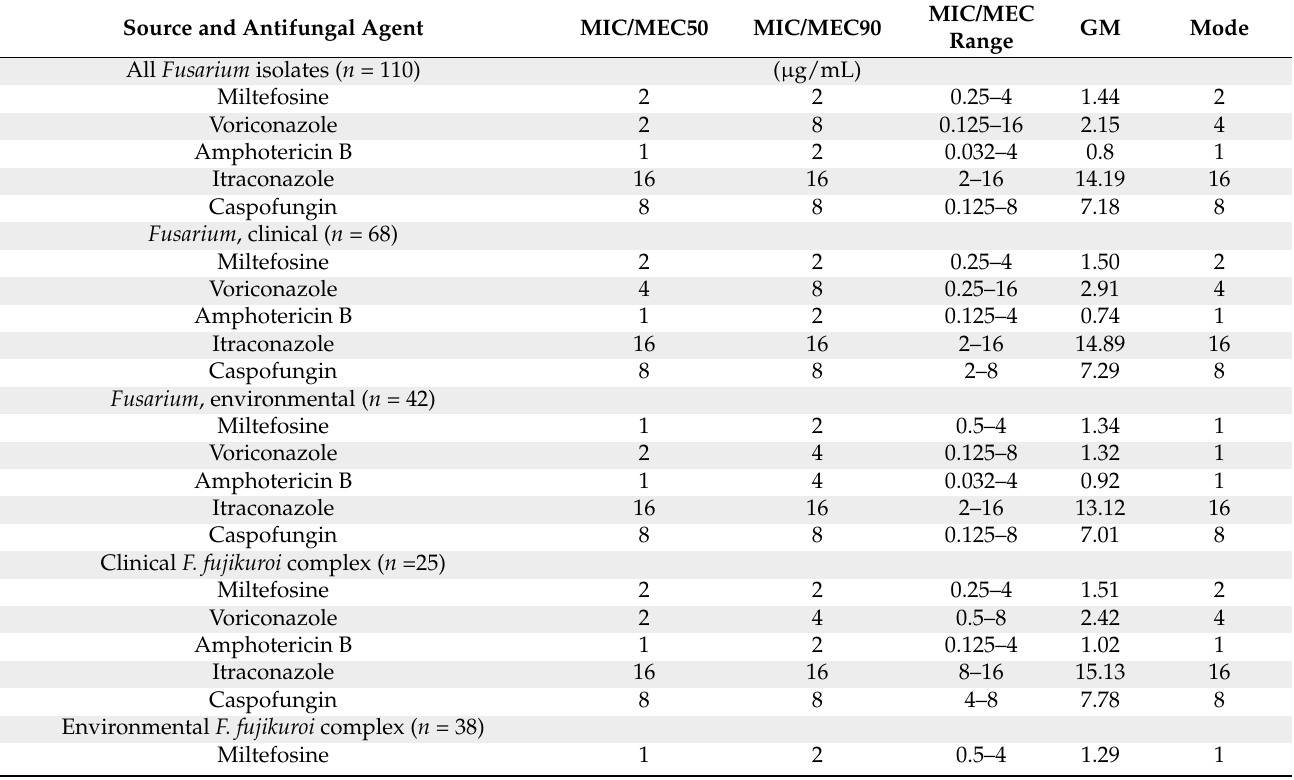
Table 1. In vitro susceptibilities of miltefosine in comparison with four antifungal drugs against 110 Fusarium isolates from different species